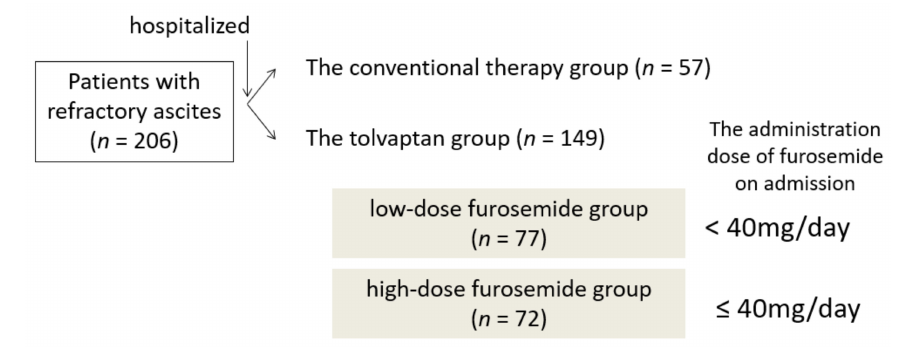
Figure 1. Scheme of this study.